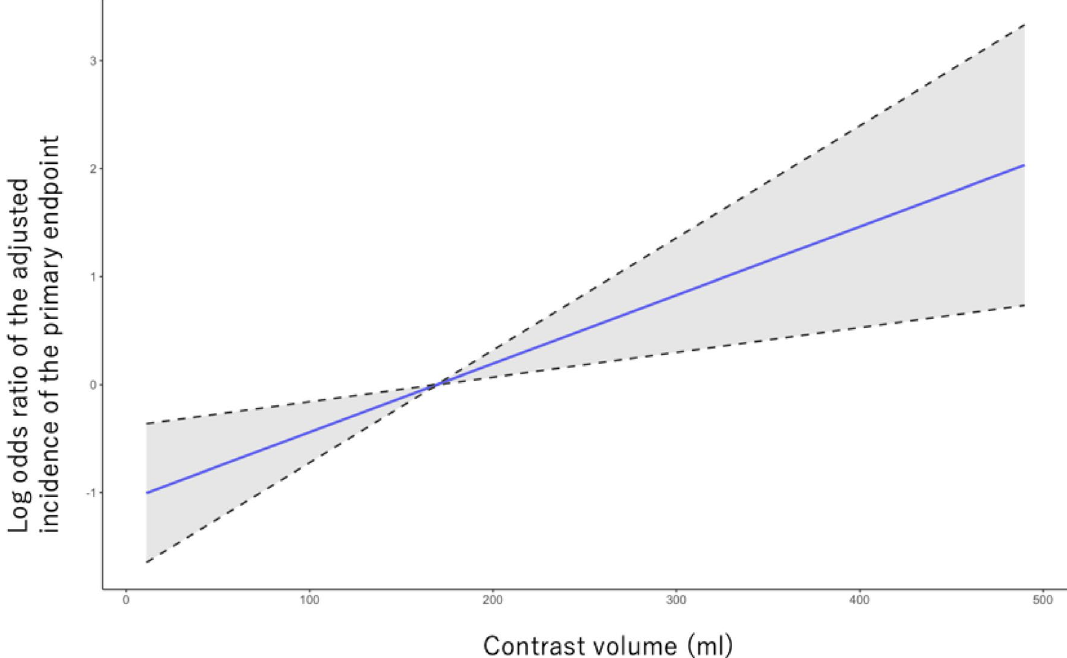
Figure 1. Smooth spline showing the association between contrast volume and the primary endpoint. The y axis shows the log odds ratio of the adjusted incidence of the primary endpoint. The x axis shows the contrast volume. The gray area shows the confidence